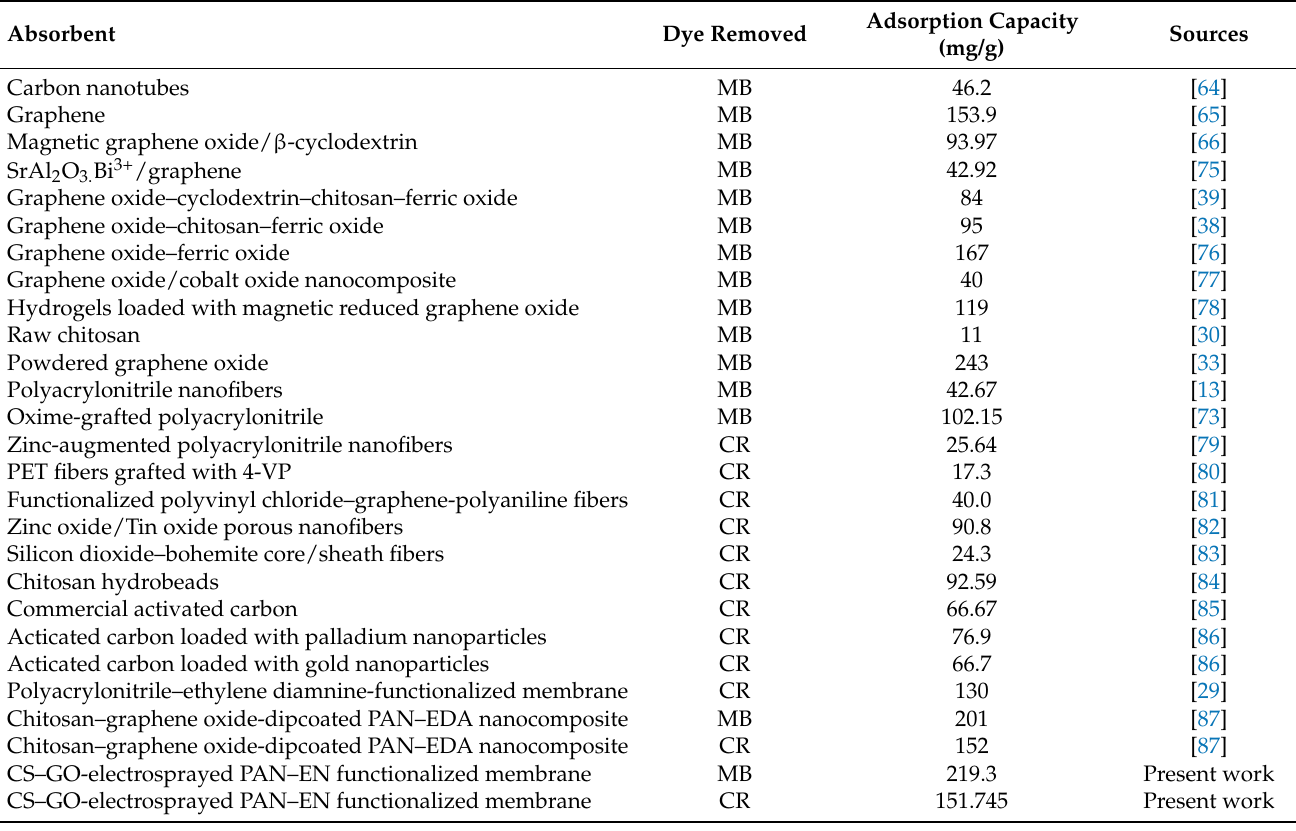
Table 4. Comparison of several adsorbents’ adsorption capacities for MB and CR.